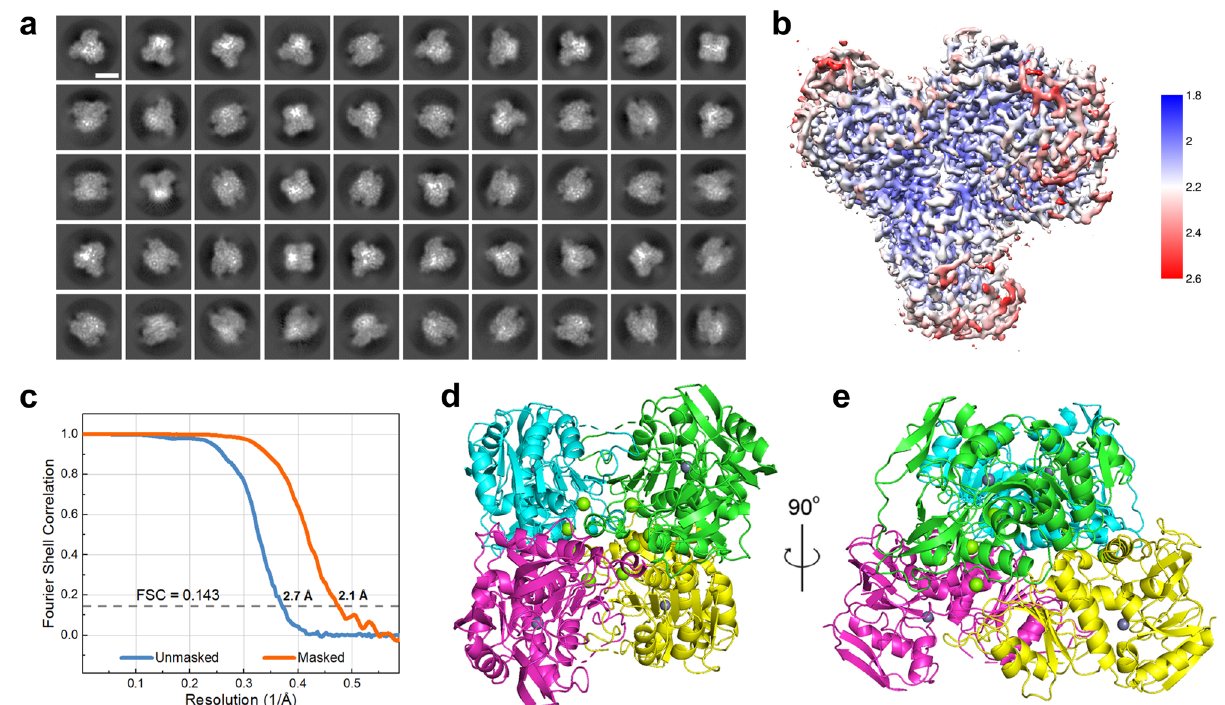
Fig. 5 | Cryo-EM structural determination of the EAG enzyme. a Representative 2D class average of enzyme particle images. Scale bar, 5nm. b A D2 density map with a near-atomic resolution. Map is colored according to the local resolution values estimated using RELION. Color key on the right shows the local structural resolution expressed in angstroms (A ̊ ). c Fourier shell correlation (FSC) curves obtained for the masked (orange) and unmasked (blue) maps with the gold-